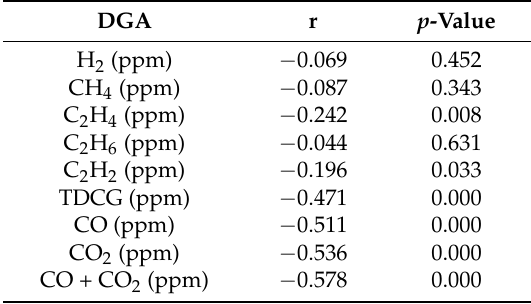
Table 6. The correlation coefficients of DP against the dissolved gasses for oil-filled transformers.